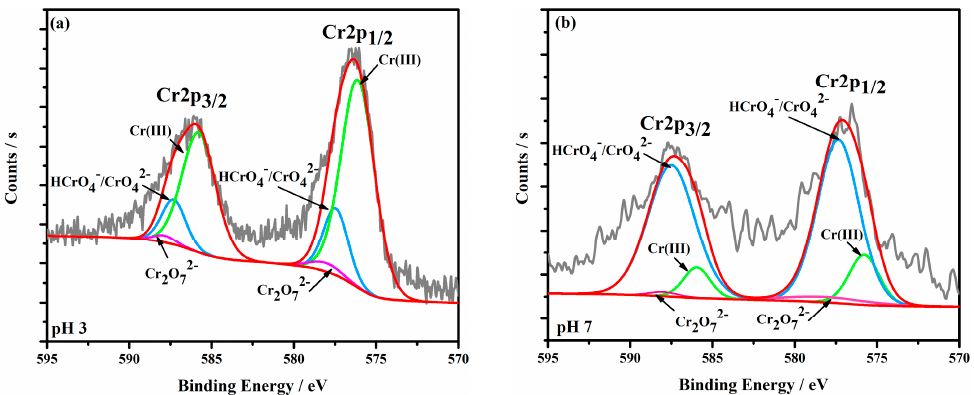
Figure 10. The Cr2p decomposition spectra of MnFe2O4 − Cr at pH = 3 ( a ) and pH = 7 ( b ).